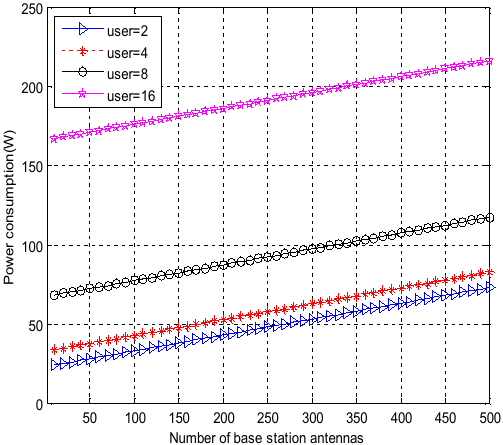
Figure 3 . Relationship between power consumption and transmitting antennas number Figure 4 is an energy efficiency comparison